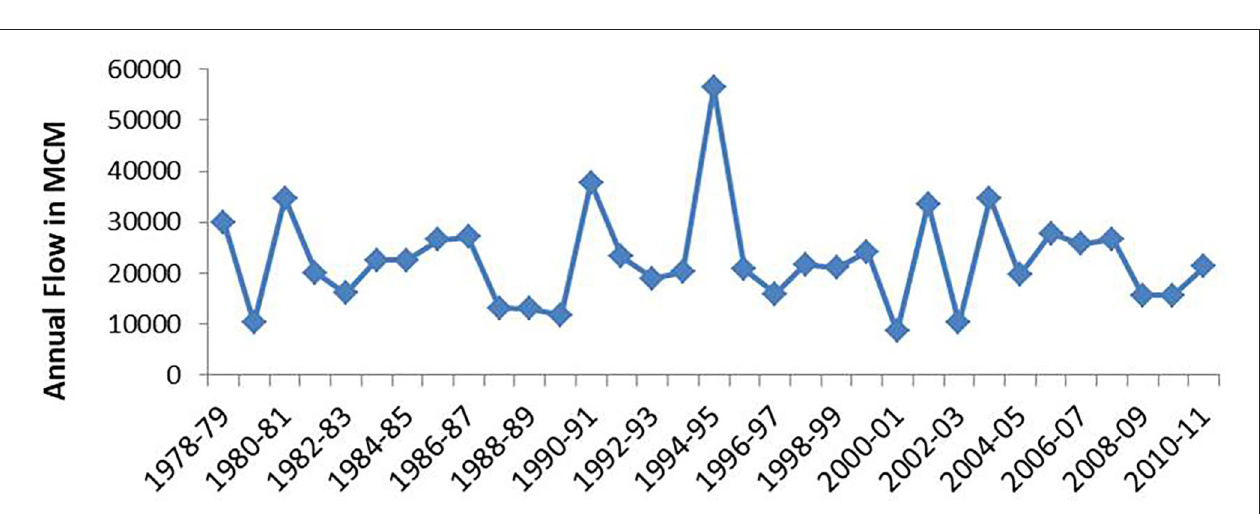
FIGURE 4 | Estimated streamflows u/s of the Hirakud reservoir. Source: Authors’ own estimates using CWC